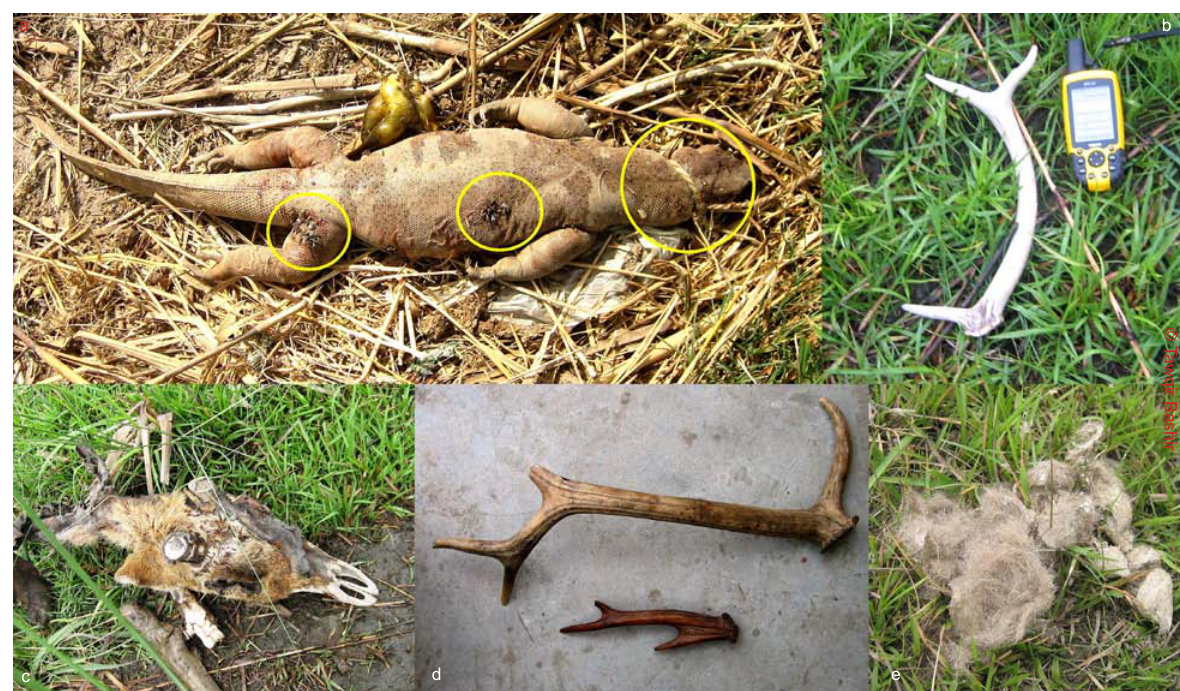
Image 1. (a) Monitor Lizard carcas with deadly wounds; (b) Swamp Deer antler; (c) Swamp Deer carcas with cut antlers; (d) Swamp and Hog deer antlers recovered; (e) Fishing Cat scat